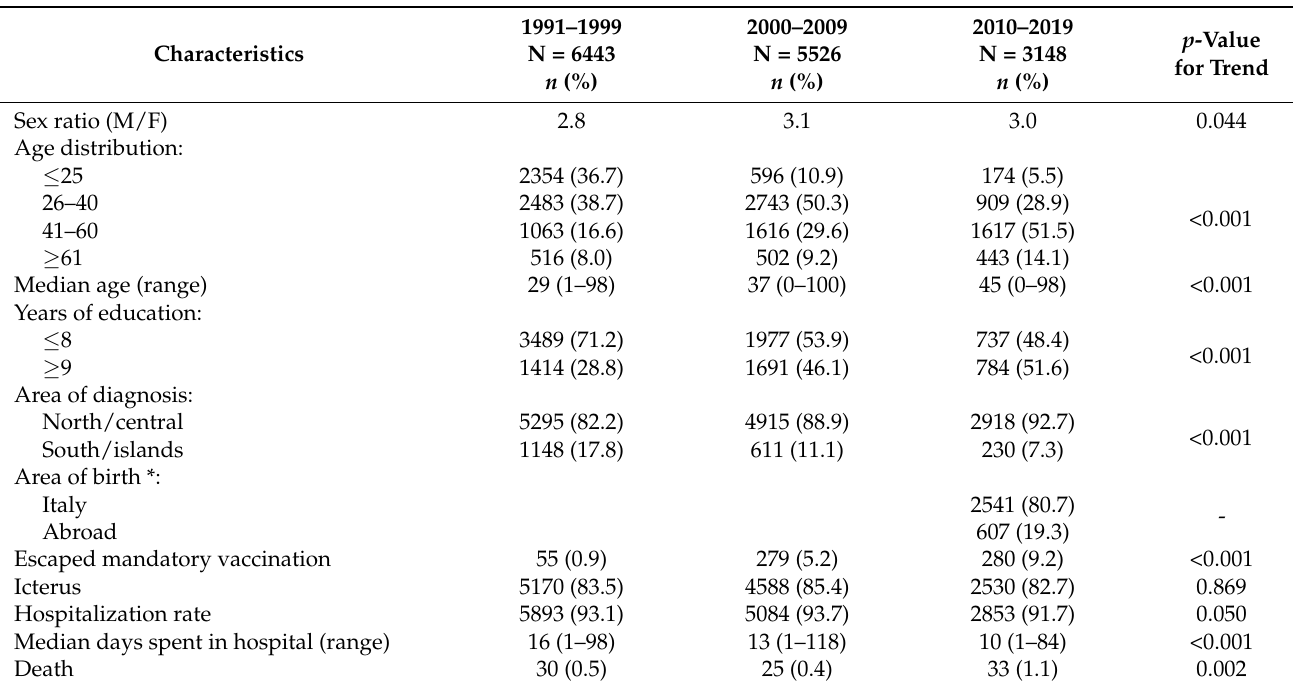
Table 1. Main features of acute hepatitis B in Italy by decade. SEIEVA 1991–2019.